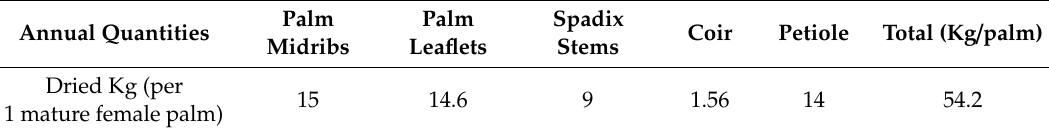
Table 1. Estimated amounts of the products of the annual pruning process of Siwi Species (10% moisture content) [3].